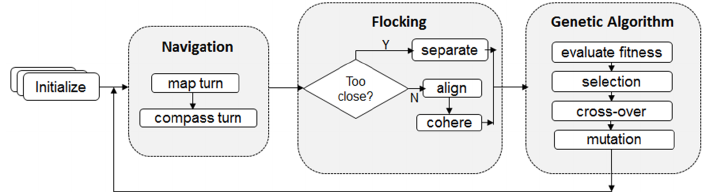
Figure 1. Flow diagram of critical steps in the model including initialization, navigation, flocking, and genetic algorithm implementation within the model.